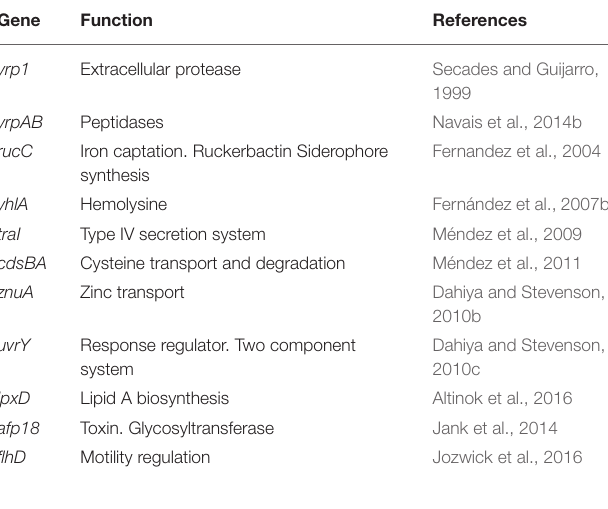
TABLE 1 | Virulence related genes of Y. ruckeri